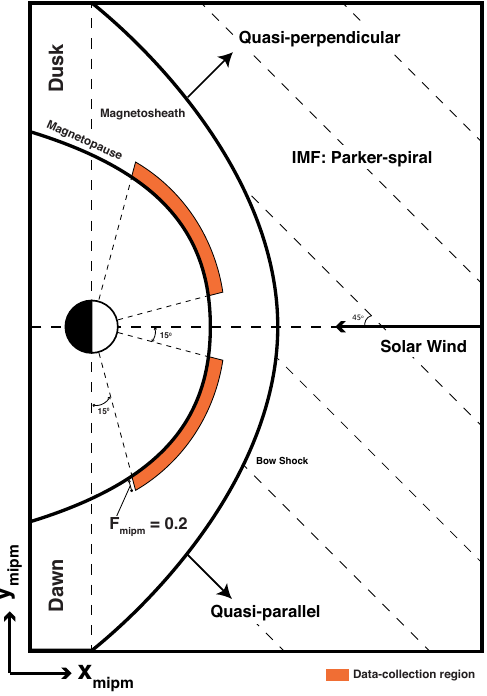
Figure 1. Diagram of the MIPM dayside magnetosheath in which all significant regions and boundaries are labelled. The filled or- ange sectors demonstrate the data collection region employed in the present study. Please note the following: (1) the figure is not to scale and (2) in physical space, the collection region scales with the mag- netosheath width and is therefore larger on the